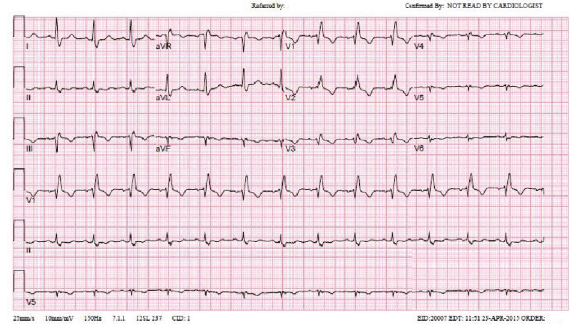
Figure 2: Preoperative/4 months after prior takotsubo cardiomy- opathy (preop pics).